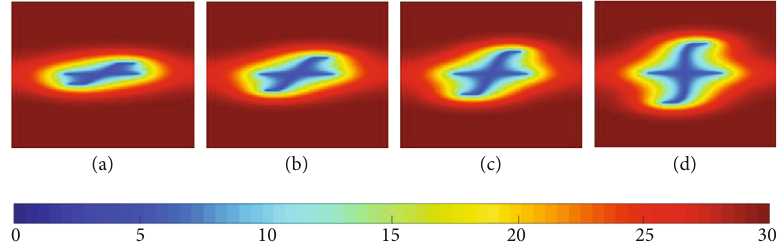
Figure 6: Pressure fi elds of the 2000 th day with di ff erent refracture azimuths (MPa): (a) θ = 90 ° , (b) θ = 45 ° , (c) θ = 60 ° , and (d) θ = 90 ° .